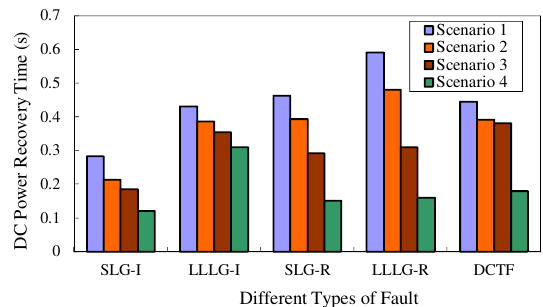
Fig.6(a-e): DC Power Recovery Time for different Faults at different locations